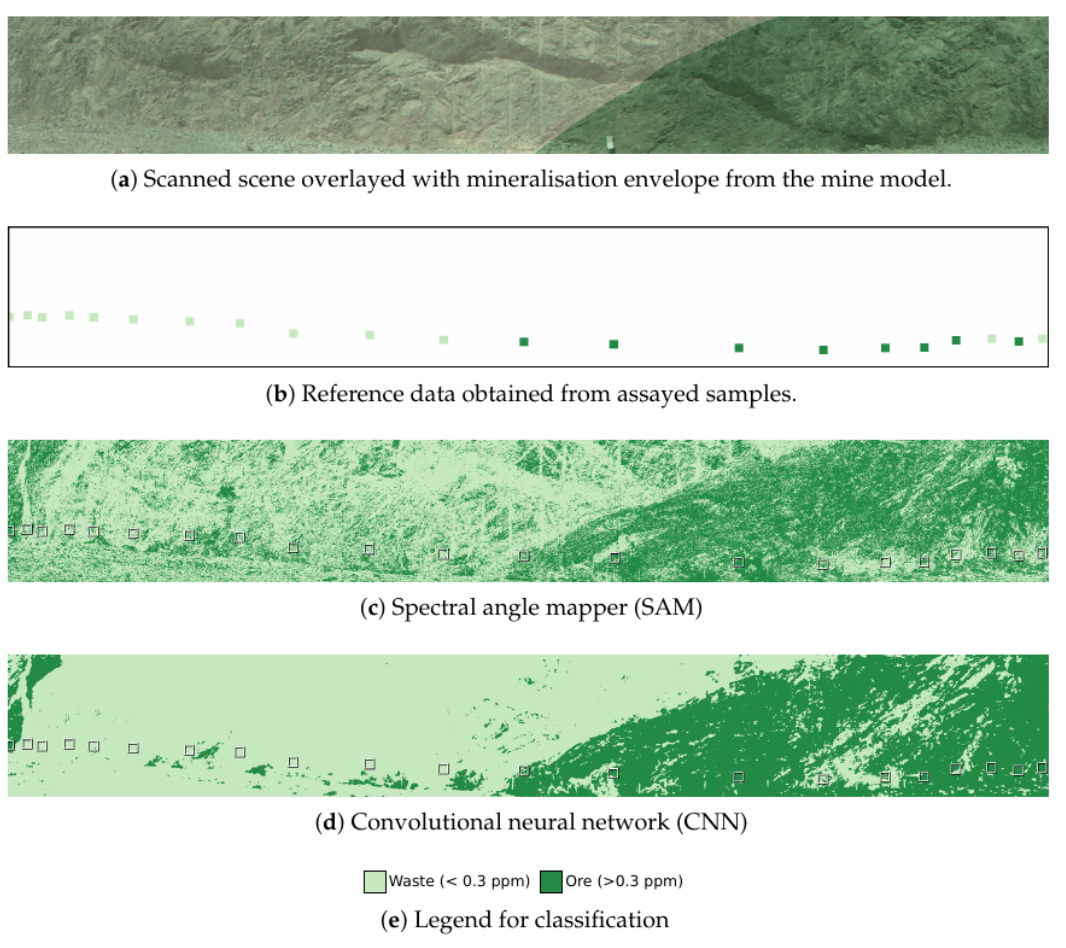
Figure 5. Reference data and results for the binary classification problem with the waste vs. ore boundary at 0.3ppm. Reference data show the mine mineralisation envelope boundary and the classes of the assayed samples obtained from the face. Results of the classification for both SAM and the CNN are shown. Classification results are coloured by one of the two grade classifications, as shown in the legend, with a bounding box around the regions labelled in the reference